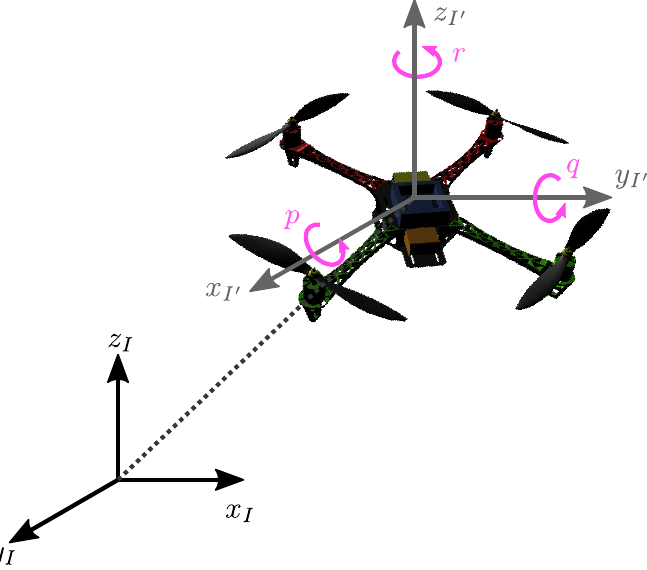
Figure 3. Angular velocity of the quadrotor concerning the three main axes in the frame { I }